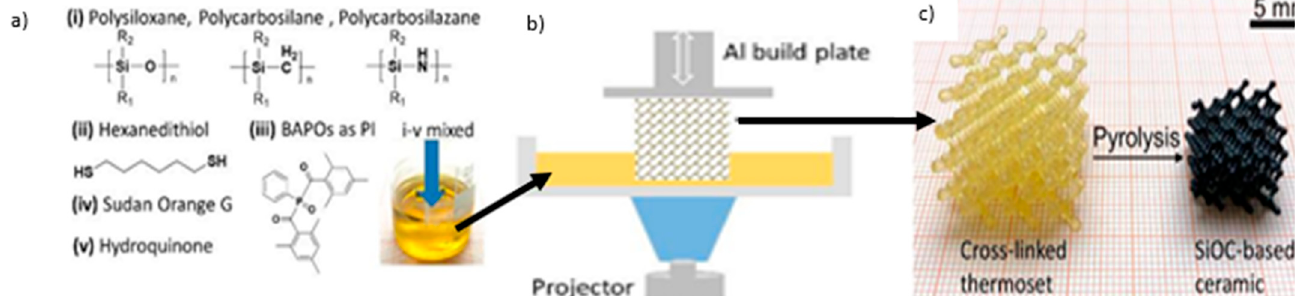
Figure 33. A schematic representation of 3D printed preceramic polymers [151].